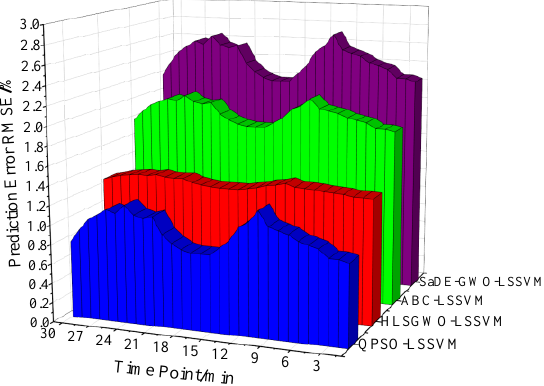
Figure 8. The distribution diagram of RMSE.